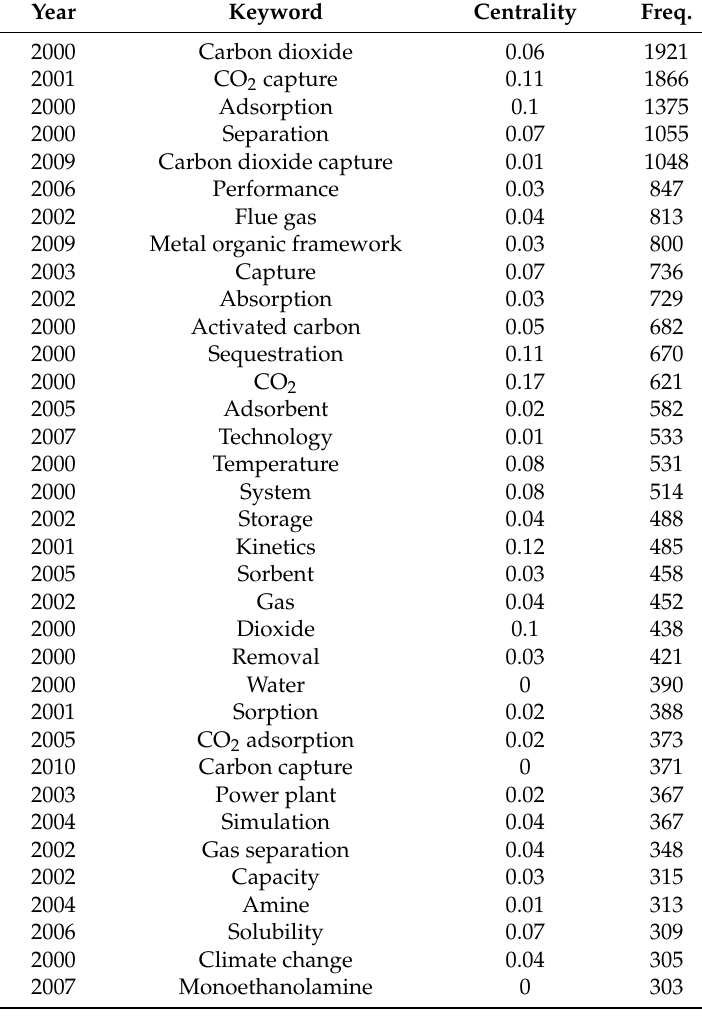
Table 4. Main research topics by year. Keyword Centrality